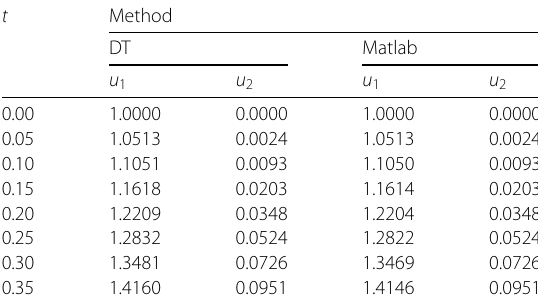
Table 8 Comparison of computing time t Method DT Matlab u